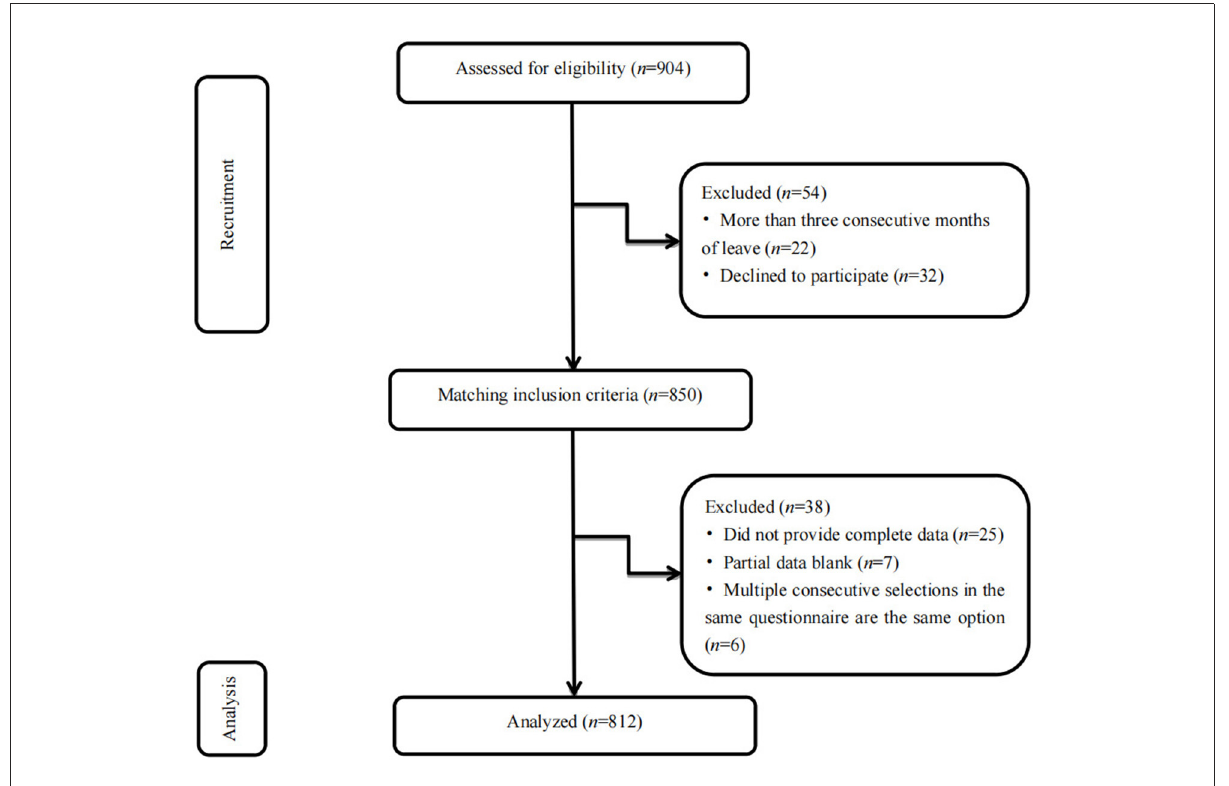
FIGURE1 Flow diagram of subjects recruitment and study selection ( n = 812, Shandong,